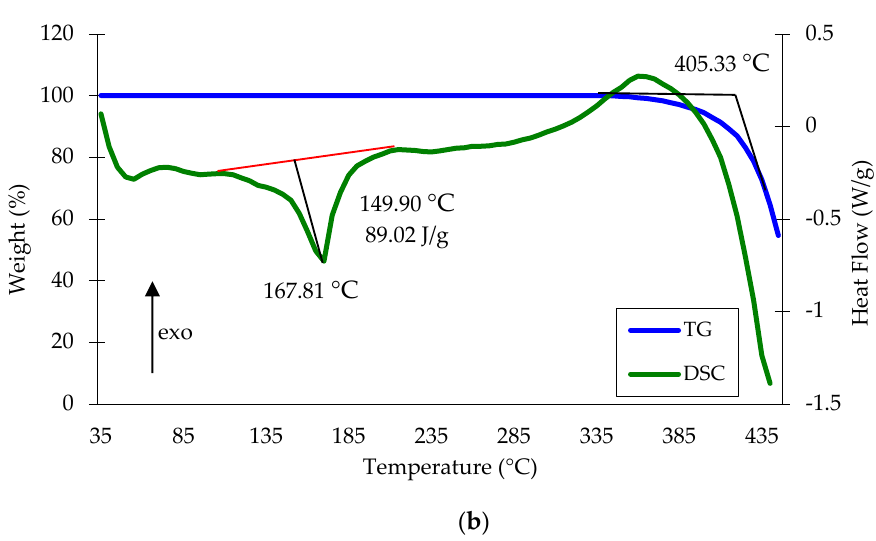
Figure 18. DSC and TG curves of polypropylene waste ( a ) and metalized polypropylene waste ( b ) (copper content 5 wt.%).